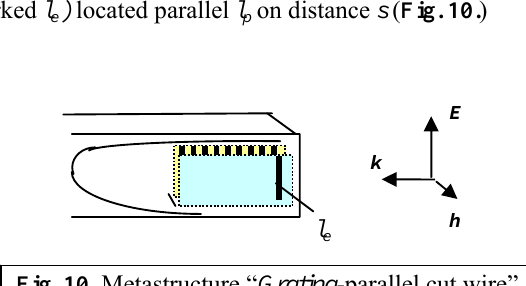
Fig. 10 . Metastructure “ Grating -parallel cut